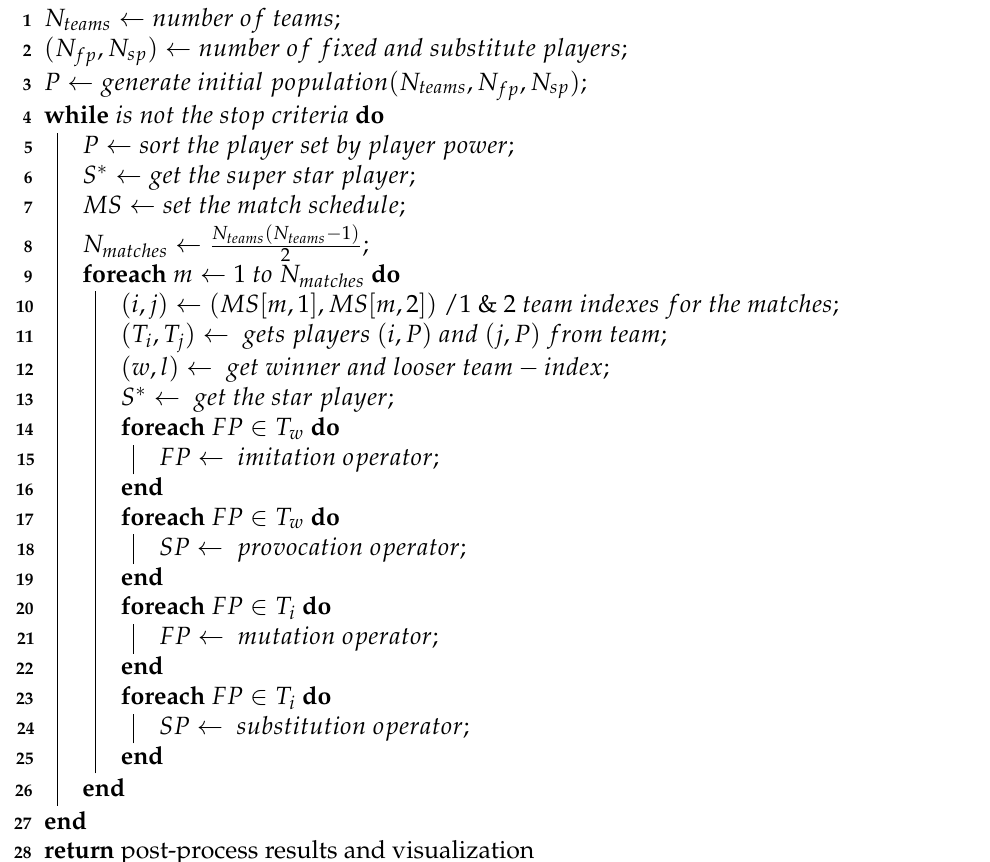
Algorithm 2: Soccer league competition